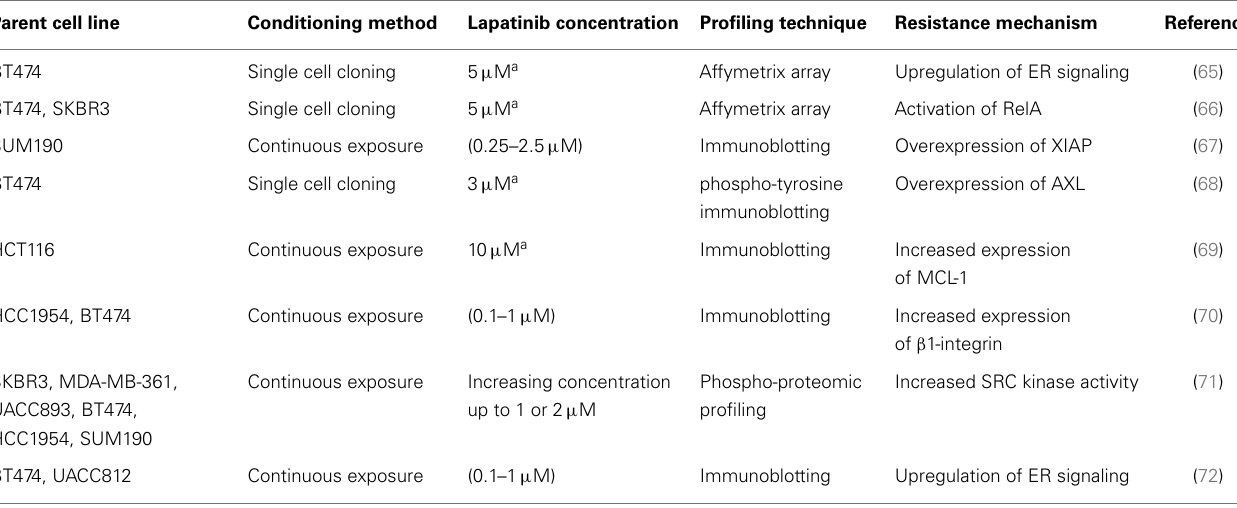
Table 5 | Published cell line models of acquired lapatinib resistance, the method and concentration used to condition the cells and the proposed mechanism of lapatinib resistance